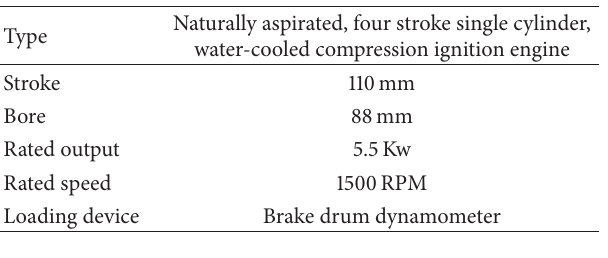
Table 3: Engine specifications.